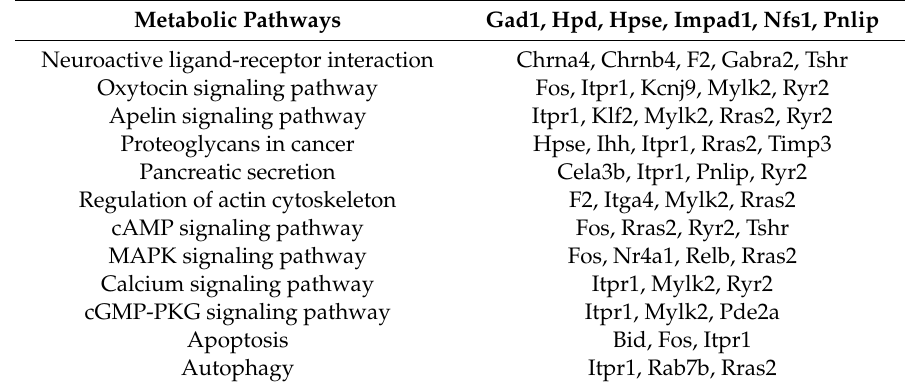
Table 2. A list of the functions and key genes of the corresponding physiological pathways impacted by cerulein in AR42J